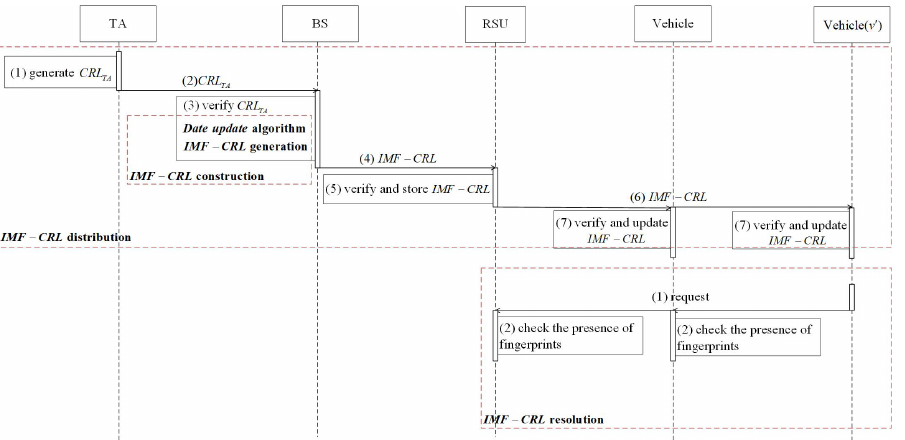
Figure 6. The flow diagram of the proposed